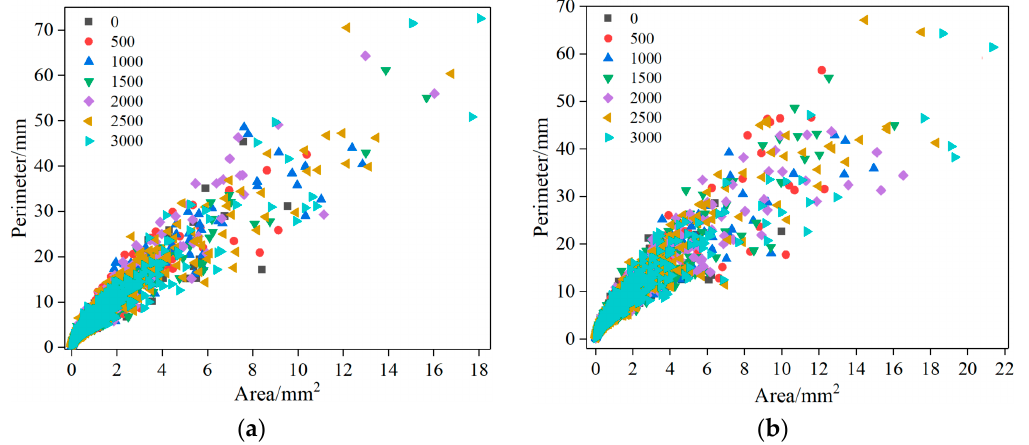
Figure 16. Relationship between air-void area and perimeter: ( a ) AC-13; ( b )